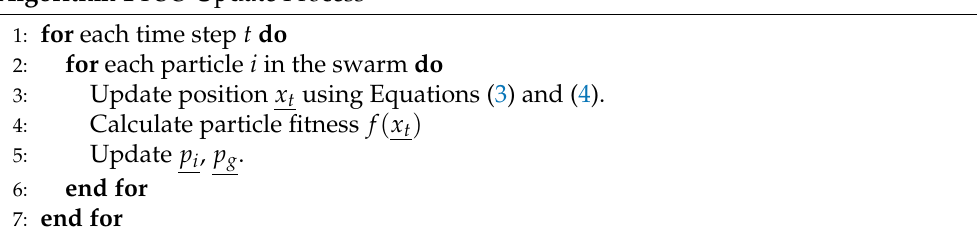
Algorithm 1 PSO Update